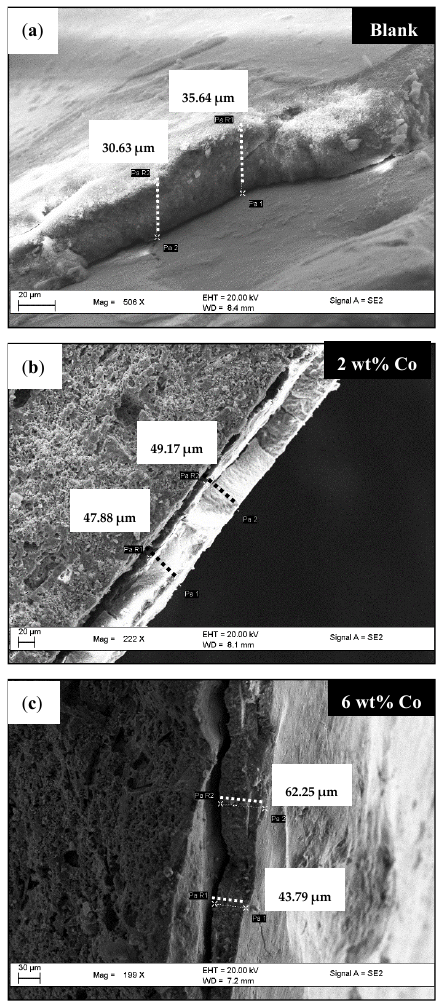
Figure 15. SEM images of catalyst coating thickness; ( a ) blank, ( b ) 2 wt% Co, ( c ) 6 wt% Co.